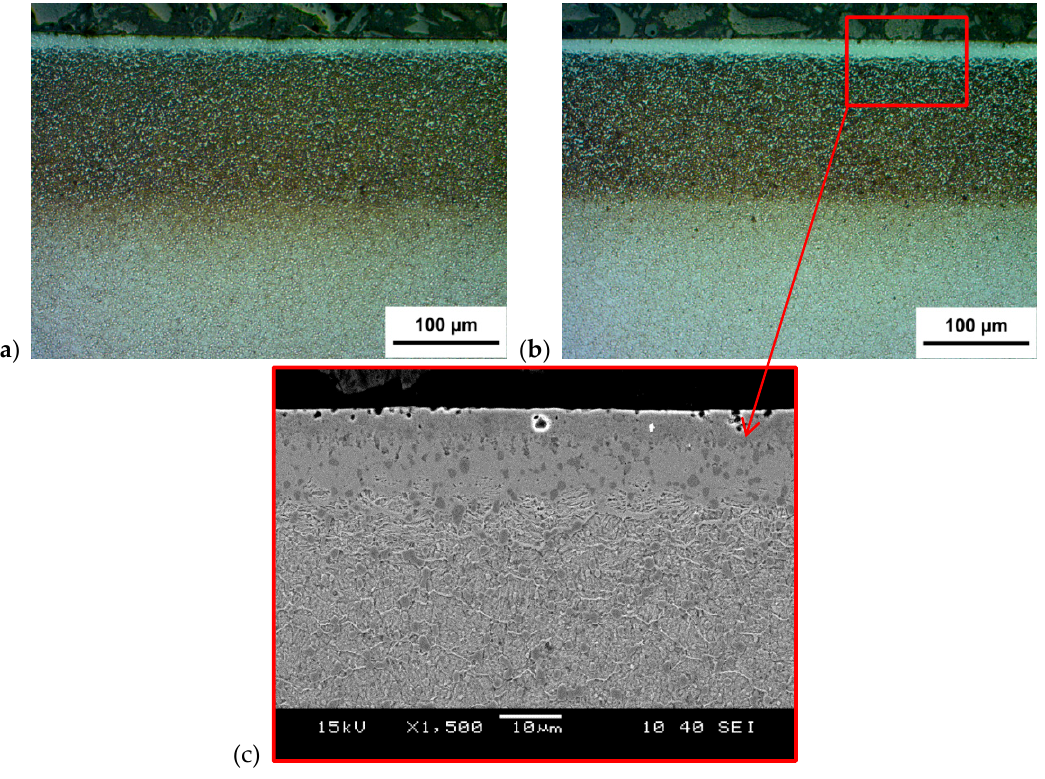
Figure 5. Optical photographs of a cross-section of SL of Vanadis 8 steel after: ( a ) G-SN; ( b ) T-B130-SN; ( c ) image of SL recorded by the scanning electron microscope.